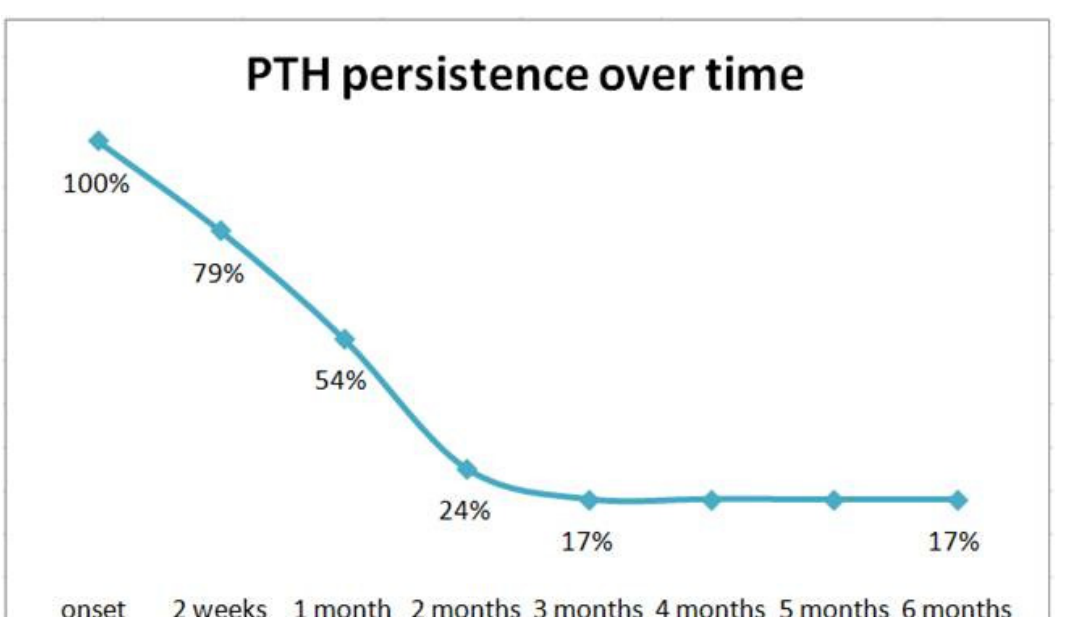
Figure 3. Day of appearance of post-traumatic headache (PTH) after minor head trauma (MHT) in 25 children aged 3–14 years.